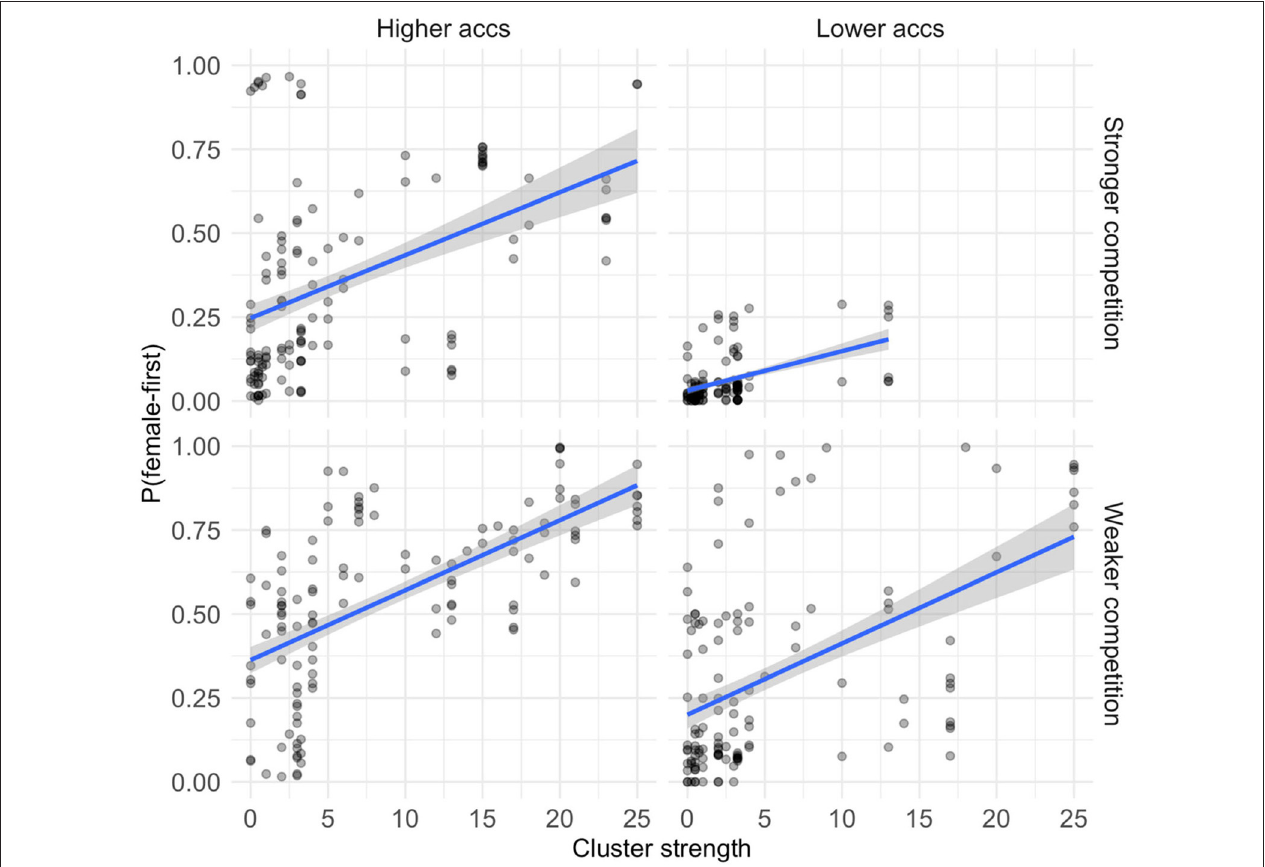
FIGURE 7 | Scatterplots depicting the correlation of cluster strength on the probability of female-first order in the following decade, plotted separately for stronger and weaker competition and for higher and lower relative accessibility of the female term. Data is separated along the median values for both competition (log frequency of male-first order) and relative accessibility. Log-frequency of the binomials to capture the interaction between frequency and cluster strength.